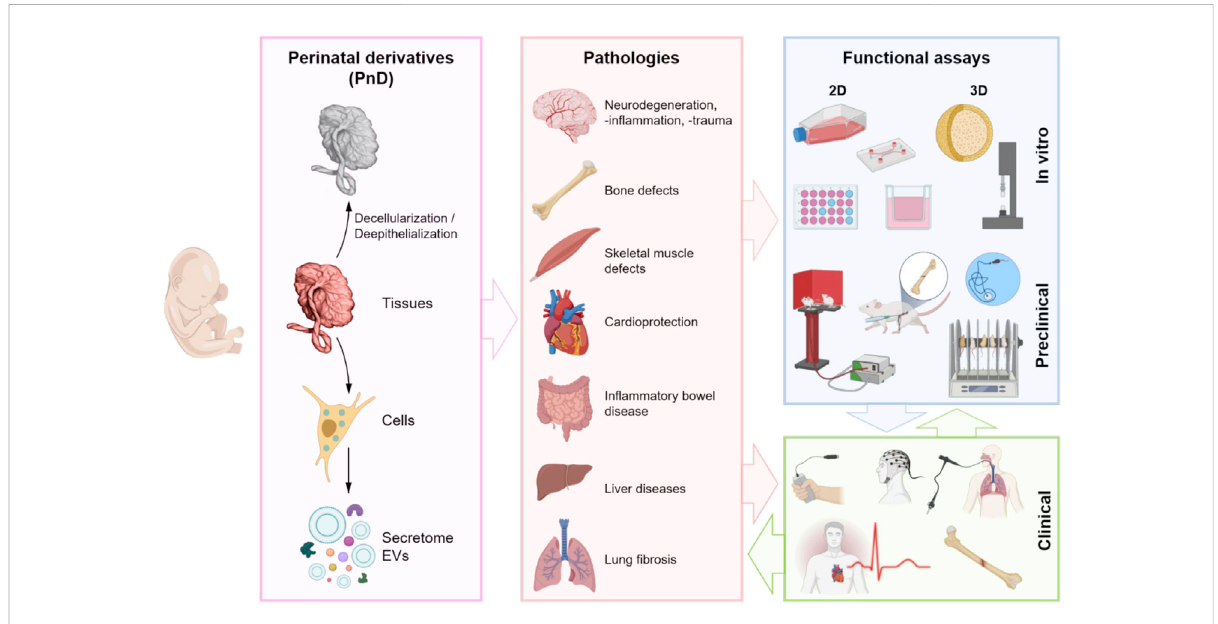
FIGURE 2 Schematic representation of the use of different PnD (tissues, cells, and paracrine derivatives — secretome (whole soluble factors including EVs) and isolated EVs), their application in different diseased organs and the functional assays. Created with BioRender.com.